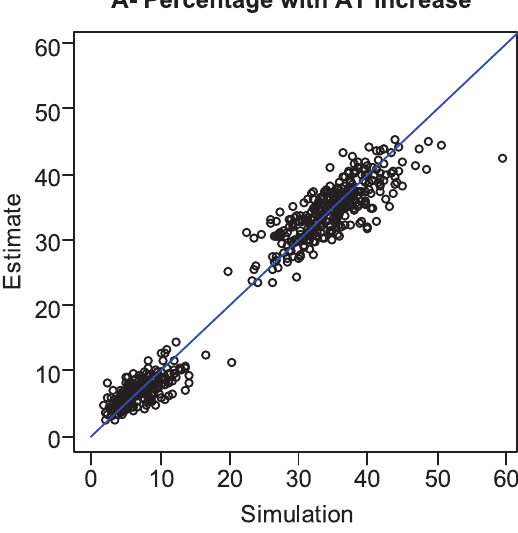
Figure 6. Performance of the method to reconstruct the true distribution of paired serology. Eighty datasets are simulated with known parameters (see Methods). A : Estimated percentage of subjects with an increase in antibody titers as a function of the true percentage in the simulated dataset. B : Estimated percentage of subjects with a decay in antibody titers as a function of the true percentage in the simulated dataset. C : Estimated probabilities characterizing jointly baseline AT level and the change in AT level during the epidemic _ similar to those presented in Figure 1 _ as a function of the true probability in the simulated dataset.